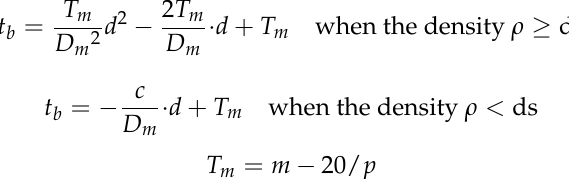
Figure 2. Deferral Forwarding Table (DFT) and an example entry.